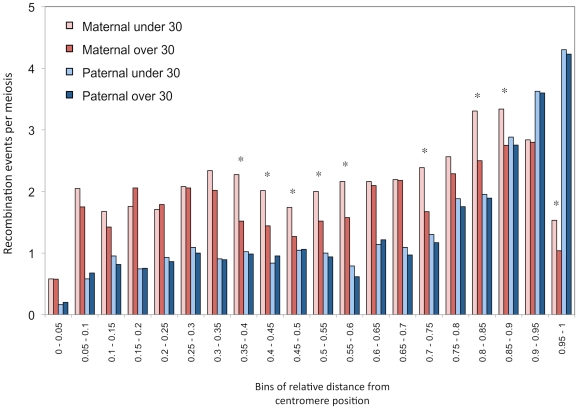
Distribution of recombination events along chromosomal arms.Histograms of mean number of events per transmission, grouped in 20 bins of relative distances from centromere (increments of 0.05 units). Paternal and maternal events are shown separately and transmissions are partitioned according to the age of the parent at birth. Parents of 30 years old are part of the over-30 groups. Significance of the shift at the 5% level (*) is assessed by permutations. All autosome arms are included.